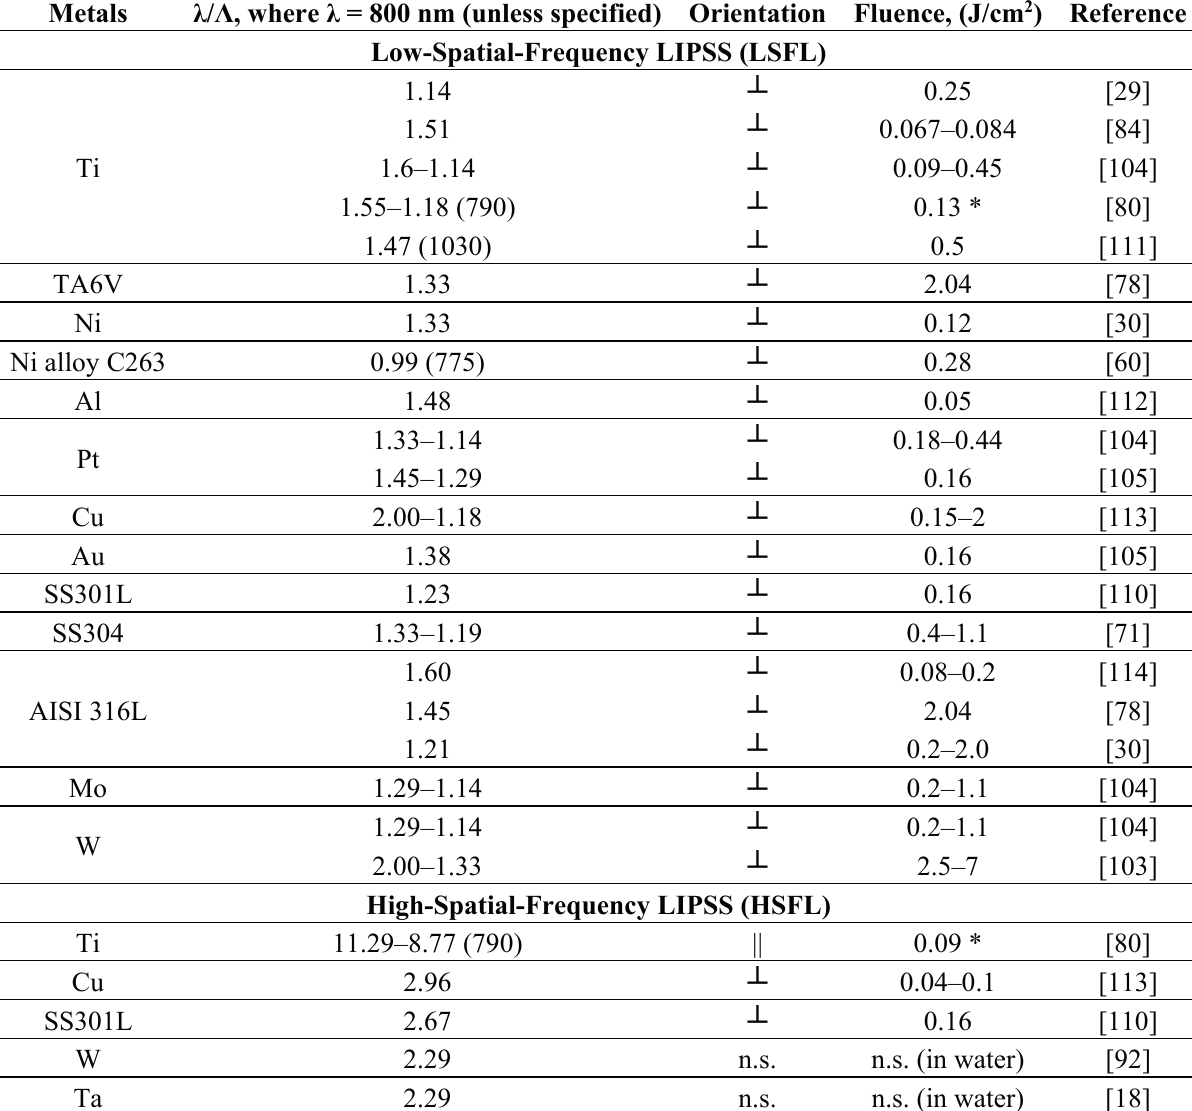
Table 3. Periodic nanostructures reported on different metals and alloys with their wavelength to periodicity ratio, fluence used to produce the features, and orientation relative to the laser polarization at perpendicular incidence. * The authors reported peak fluence values. n.s. = not